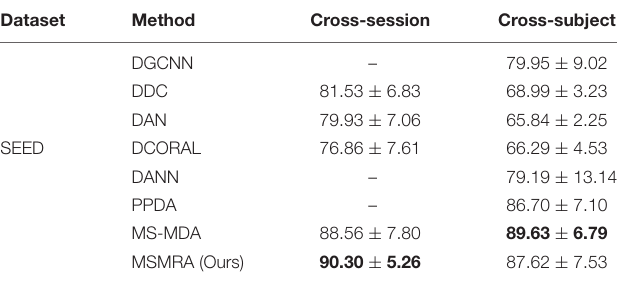
TABLE 3 | Comparisons of the average accuracies and standard deviations of cross-session and cross-subject scenarios on SEED database among the various